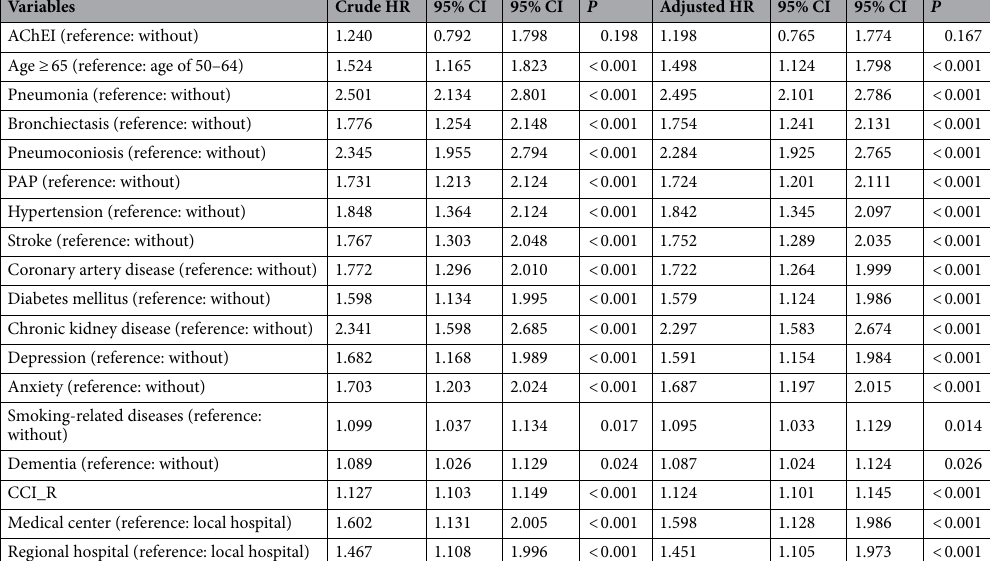
Table 2. Factors of lung cancers by using Cox regression model. HR hazard ratio, CI confidence interval, Adjusted HR Adjusted variables listed in the table 1, AChEI acetylcholinesterase inhibitors, CCI_R Charlson Comorbidity Index, dementia removed, PAP pulmonary alveolar